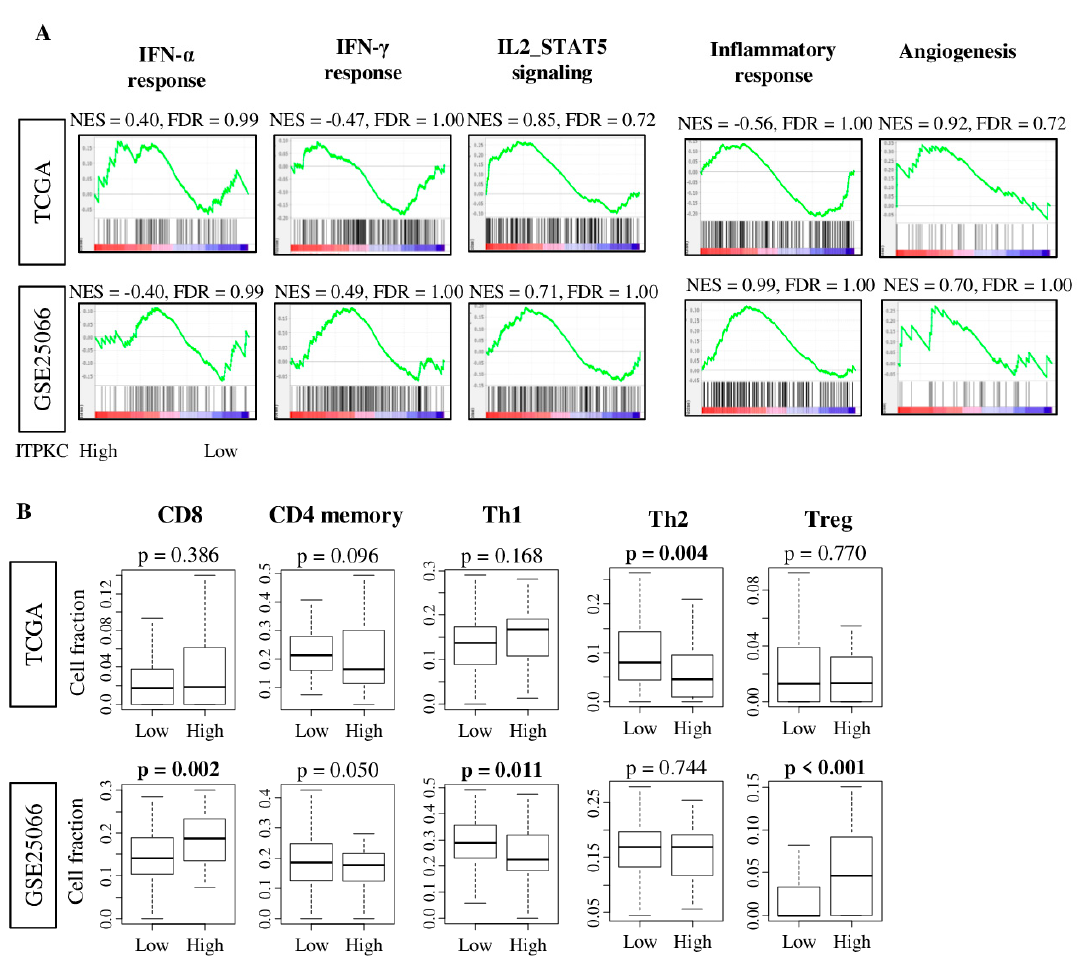
Figure 3. ITPKC gene expression and immune function and immune cell fraction with TNBC in the TCGA and GSE25066 cohorts. ( A ) Correlation plots of immune-related gene sets: interferon ( IFN )- α and γ , IL2-STAT5 signaling, IL6 / JAK / STAT3 signaling, inflammatory response and angiogenesis, with normalized enrichment score (NES) and false discovery rate (FDR). FDR < 0.25 is considered to be statistically significant. ( B ) Boxplots of the comparison with CD8, CD4 memory, T helper type 1 cells (Th1), T helper type 2 cells (Th2) and regulatory T cell (Treg), by low and high ITPKC expression in both cohorts. The top quartile was defined as the high-score group within each TNBC cohort. One-way ANOVA test was used to calculate p values. Tukey-type boxplots show median and inter-quartile level values.